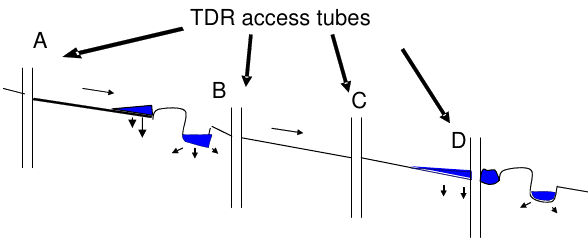
Figure 2: Functioning of fanya juu terracing with TDR soil moisture monitoring tubes Fig. 2. Schematic of a section of the cultivated field showing TDR access tubes placed to measure soil moisture variation in relation to the location of the trenches and soil bunds ( fanya juu